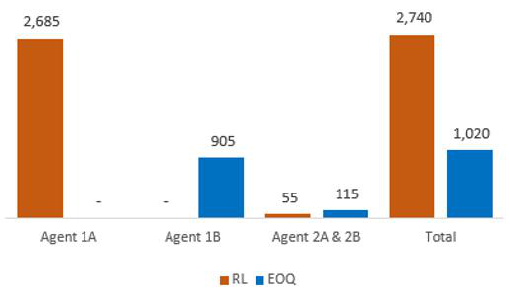
Fig. 6 Backorder Cost - Scenario